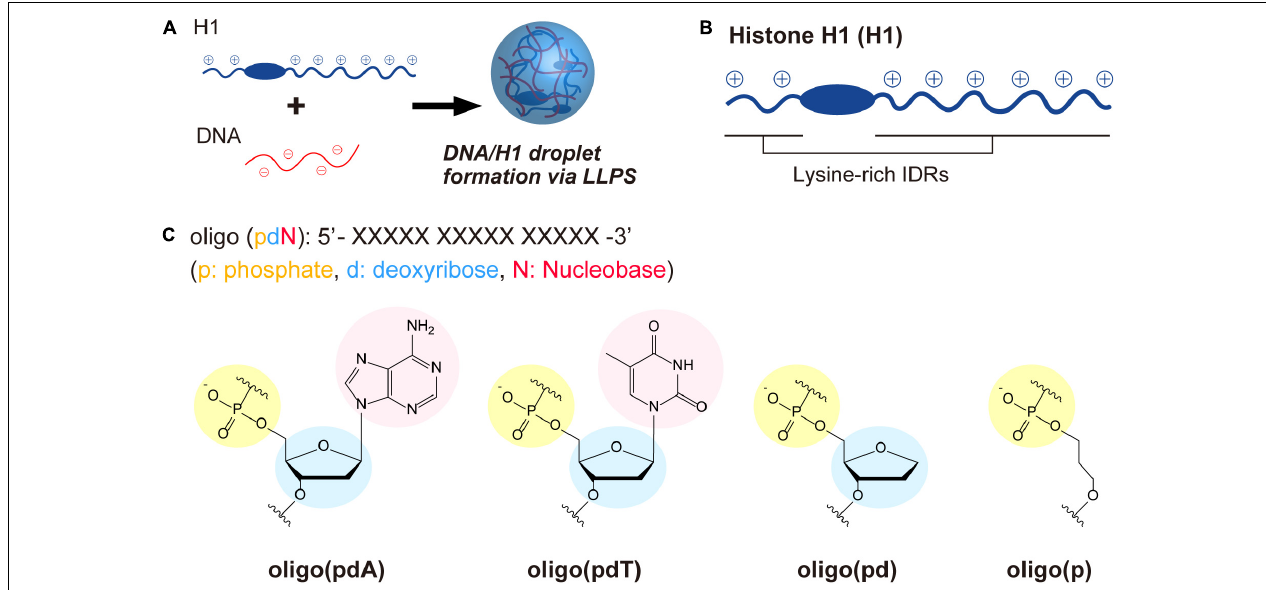
FIGURE 1 | LLPS system and molecules used in this study. (A) Schematic illustration of droplet formation in ssDNA/H1 mixtures via LLPS. (B) Structural drawing of histone H1 with lysine-rich IDRs at the N- and C-terminus. The IDRs were estimated using three different structure-prediction algorithms (for details, see the Supplementary Figure 1 ). (C) Chemical structures of the ssDNA-based